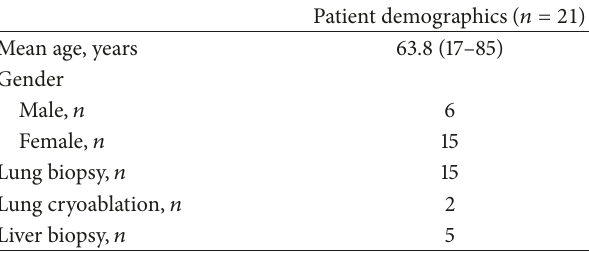
Table 1: Patient demographics.